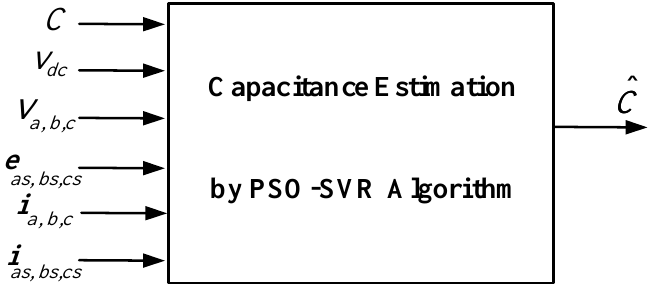
Figure 3. The structure of DC-link capacitor monitoring.